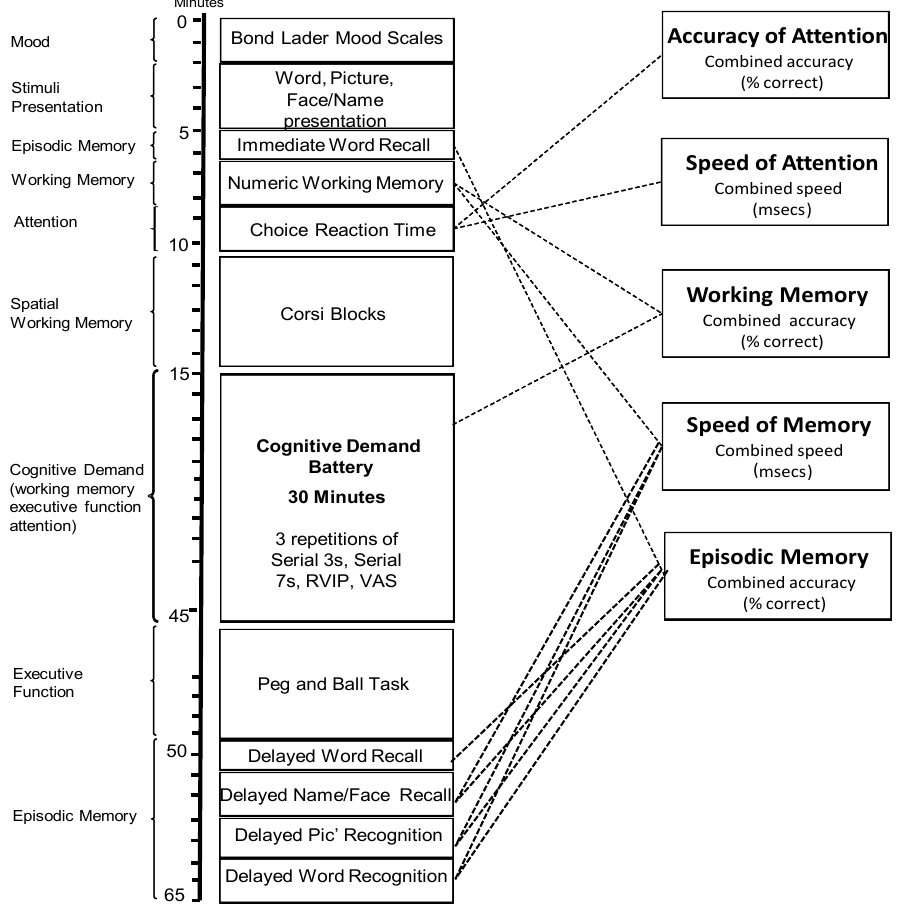
Figure 2. Cognitive task battery. Figure depicts the order of cognitive task completion during the pre-dose and two post-dose cognitive task battery completions. The left of the figure shows the approximate task timings and predominant cognitive domain of each task. The right of the diagram demonstrates how global cognitive domains can be derived from outcome measures of individual tasks. RVIP, Rapid Visual Information Processing; VAS, Bond Lader Visual Analog